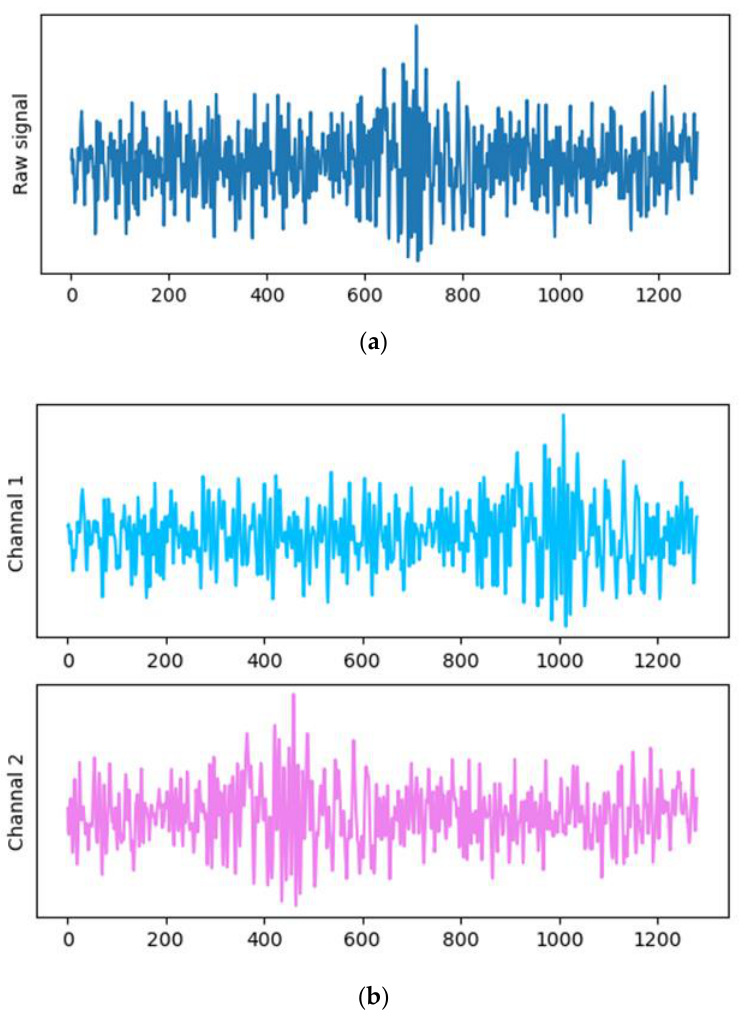
Figure 2. Schematic diagram of the horizontal scaling of the vibration signal with ( a ) the original signal and ( b ) two transformed channel signals. signal and ( b ) two transformed channel